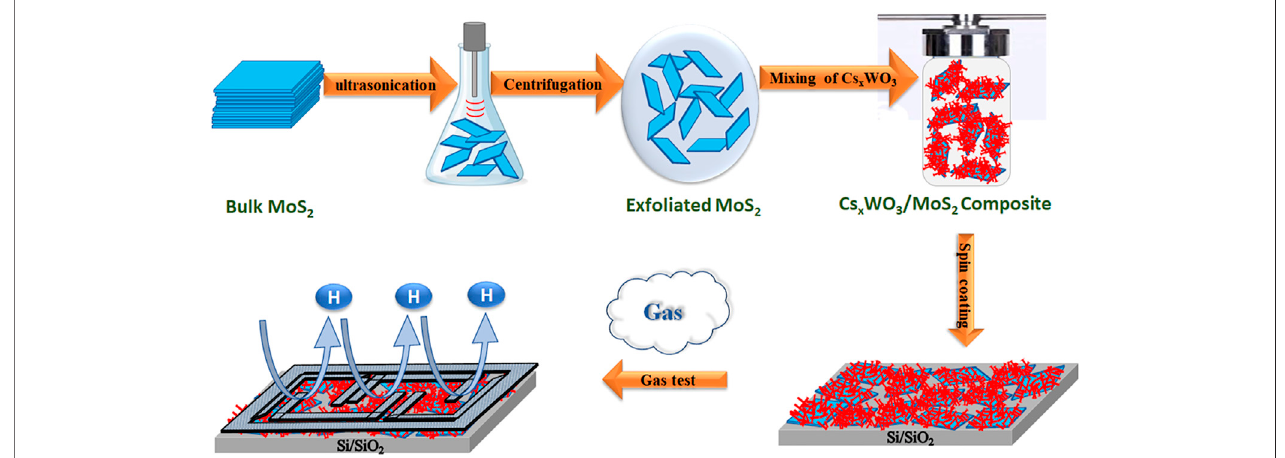
FIGURE 1 | Schematic illustration of the synthesis process of Cs x WO 3 /MoS 2 -based gas sensor.